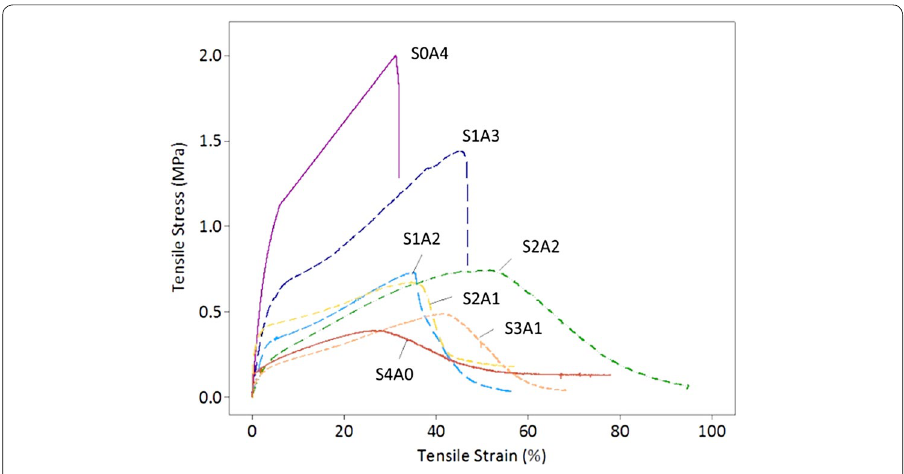
Fig. 5 Stress-strain curve for various contents PS/PA6 webs: a 4/0, b 3/1, c 2/1, d 2/2, e 1/2, f 1/3, g